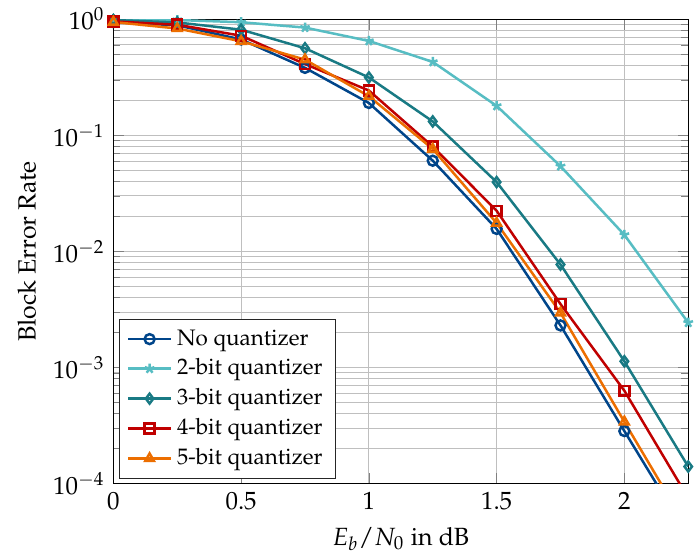
Figure 15. Block error rate of double-precision floating-point SCL decoder with channel quantizers of different resolutions designed using the information bottleneck method. N L = 32, N crc = 16, N = 1024, code rate 0.5, and design E b / N 0 = 3 dB.